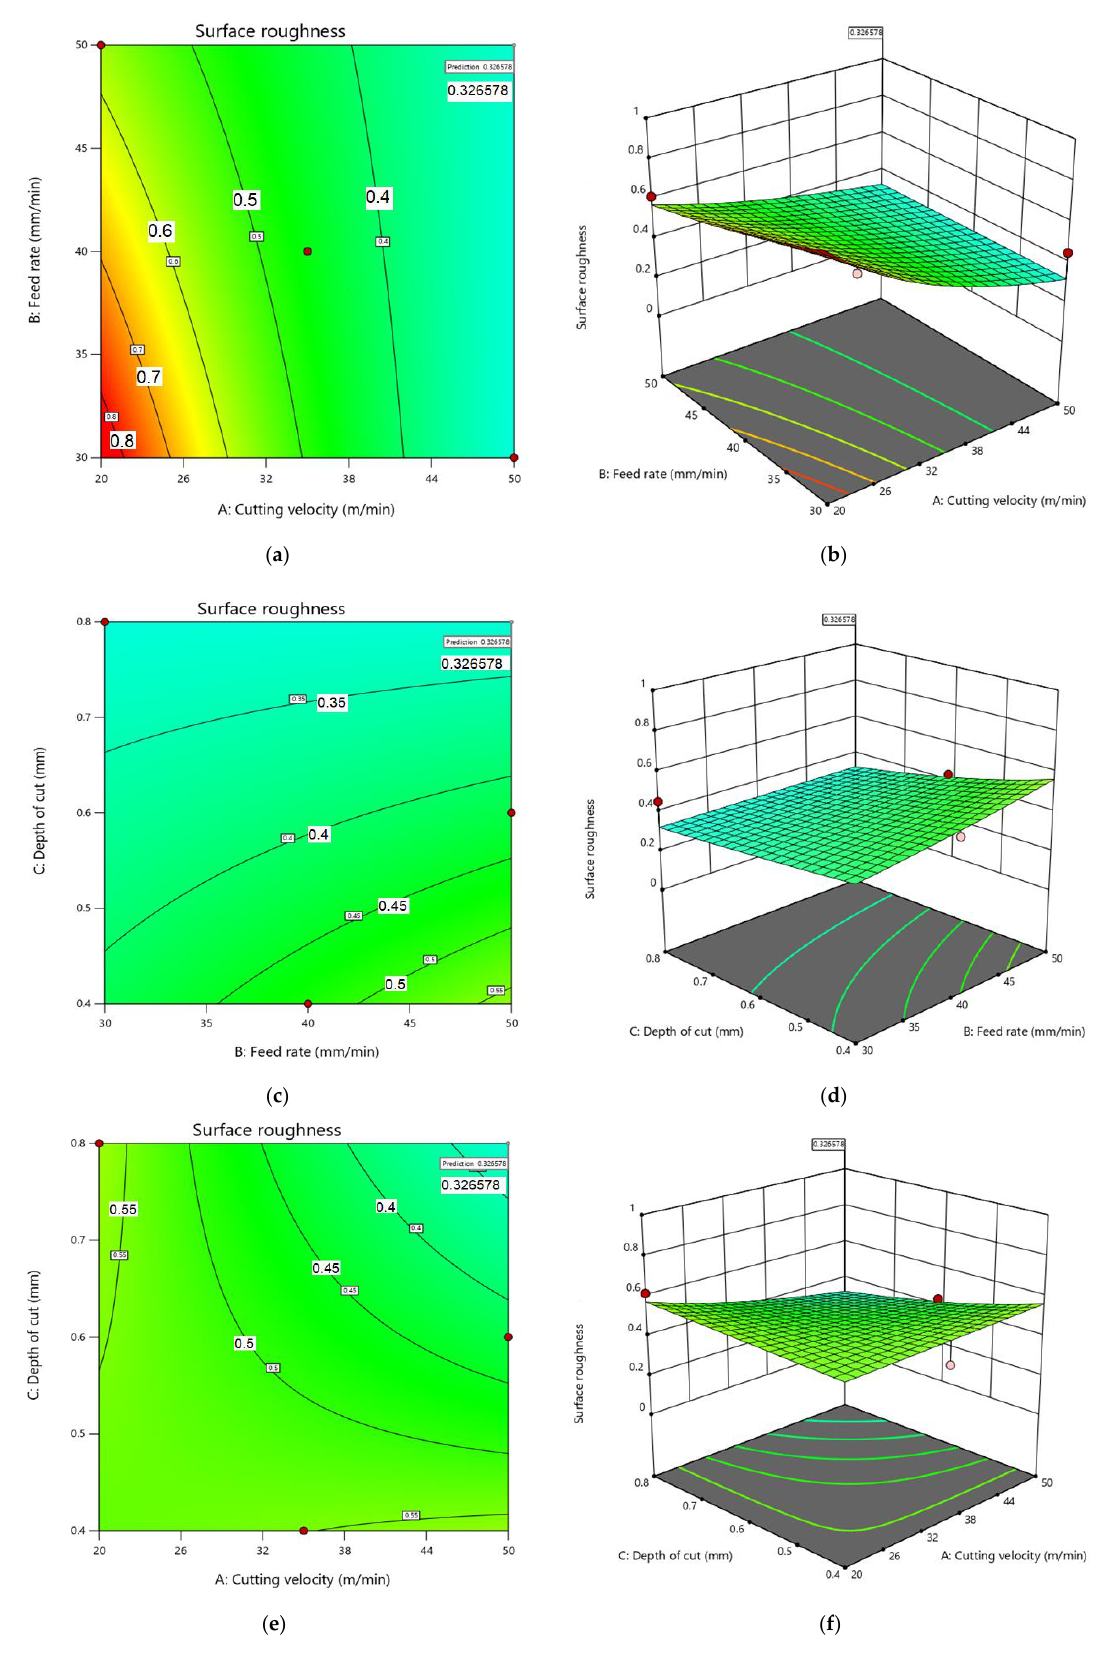
Figure 7. ( a – f ) Contour and surface plots for two interactions.